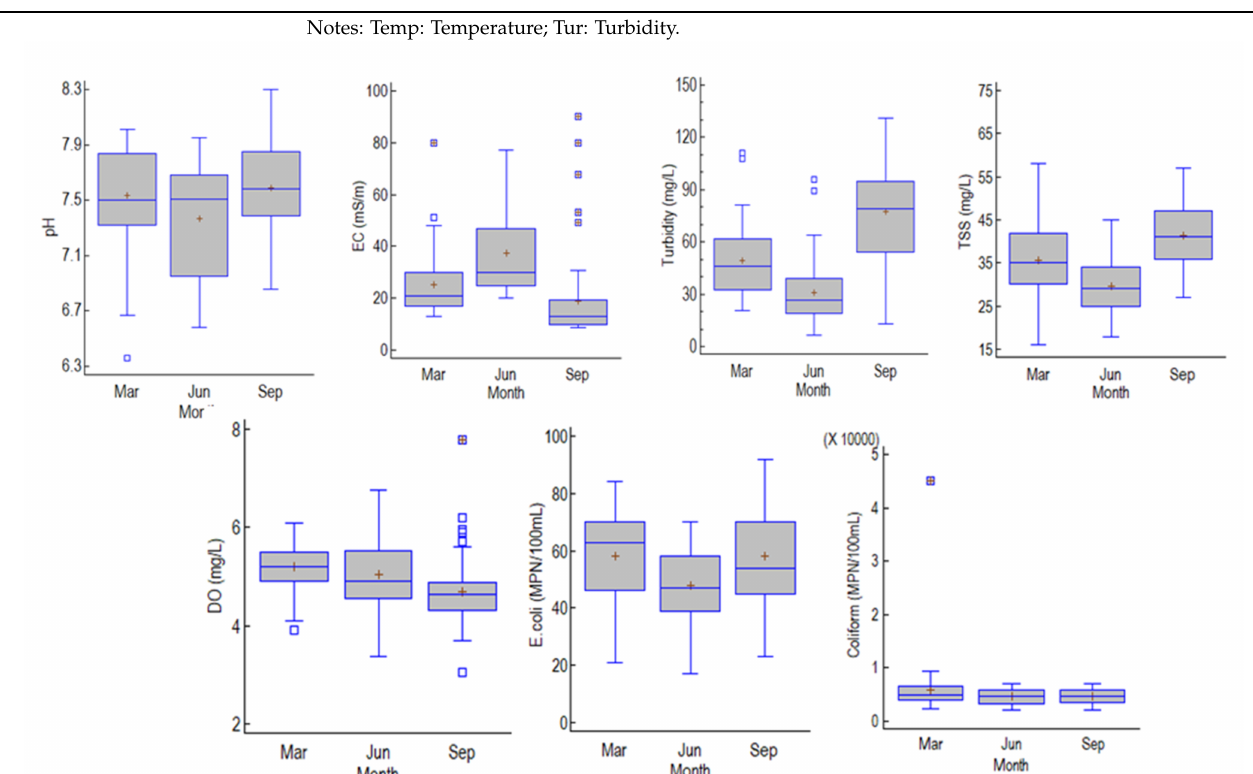
Figure 3. Temporal varying water quality